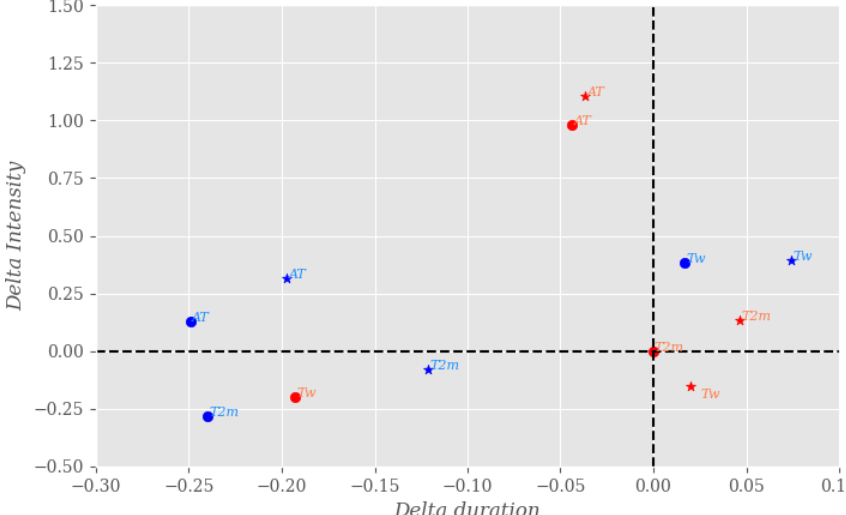
Figure 6. Sensitivity analysis of heat wave characteristics to the datasets, indicators and methodologies used in the CONT region. The characteristics investigated here are the duration and intensity. The circles and stars in the figure represent ERA5 and MERRA reanalyses respectively. The blue/red colour represents minimum/maximum values of the indicators. “ T 2m , max ” from ERA5 is the reference variable used for this analysis. The x and y axes show the standardized variation in intensity and duration from the reference (no unit) respectively. The variations in duration and intensity have been computed using max daily T 2m in ERA5 as reference. The detection of heat waves is done using the climatological daily 90th percentile over the period as a